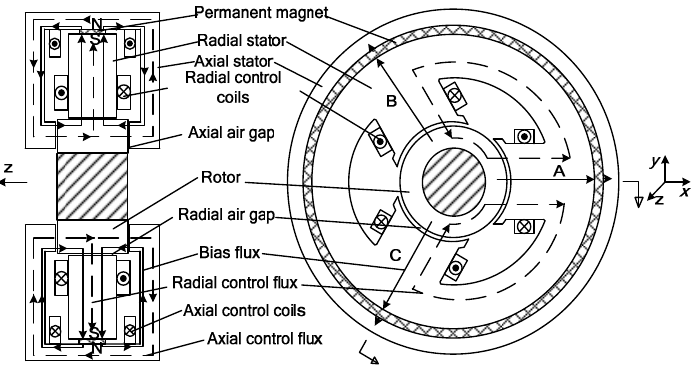
Figure 1. Structure and flux paths of three ‐ pole radial ‐ axial hybrid magnetic bearings (HMB).